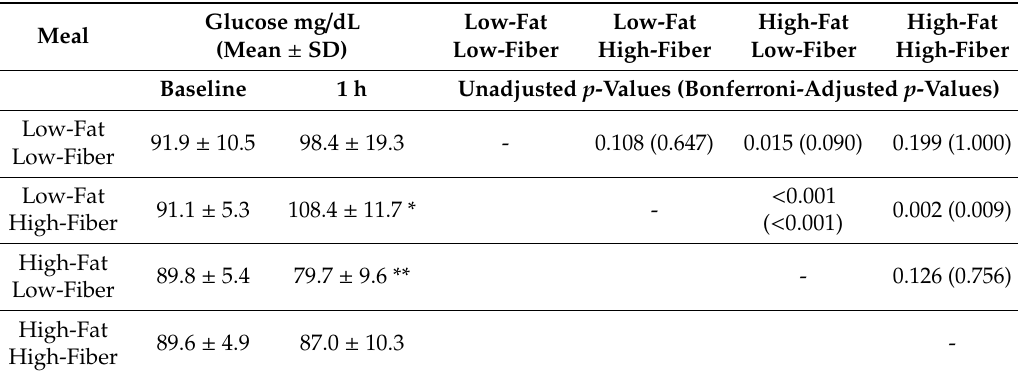
Table 3. Blood glucose changes from baseline to 1 h postprandial: comparison between meals.